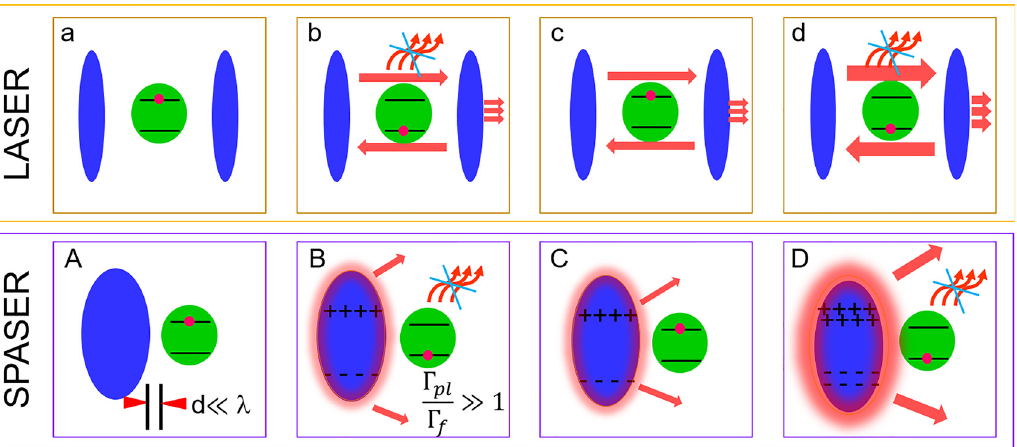
Figure 2: A step-by-step comparison between the conventional laser (top row) and the SPASER (bottom row) highlighting the key differences andsimilarities. The greencirclerepresentsan emitter andthe blueelliptical mirrors (toprow) or a plasmonic metalobject (bottomrow). a, A: the excited emitter (electron, the red dot, is in the upper state) in the presence of the cavity (a) or the plasmonic metallic structure (A) with distance,d,muchsmallerthanthewavelength, λ .b,B:Duetothepresenceofthecavity(b)orplasmonicmetal(B),spontaneousemissioninto cavity mode represented by the horizontal red arrows (b) or spontaneous energy transfer to the metallic structure to excite surface plasmon mode (the red cloud around the blue metallic structure) (B) dominates over spontaneous emissioninto free space as indicated by the crossed emission wiggles. Γ pl and Γ f stand for the rate of energy transfer to plasmons and that of emission into free space, respectively. c, C: The emitterisre-excitedinthepresenceofpre-existingcavitymode(c)andplasmonicmode(C).d,D:Thepre-existingcavitymode(d)orplasmonic oscillation (D) forces (stimulates) the excited emitter to emit the same photon (d) or plasmon (D) instead of emitting spontaneously into the free space. The continuation of step d (stimulated emission of radiation) or D (stimulated energy transfer) eventually leads to lasing (d) or spasing(D).FortheSpaserinthelowerrow,wealsoindicatethepossiblefar- fi eldemissionfromtheplasmons(redstraightarrowsinB,C,and D). It is important to note that such far- fi eld originates from the plasmon oscillation from the metallic structure, rather than from the emitter directly. The bottom row is based on an earlier version in [11].